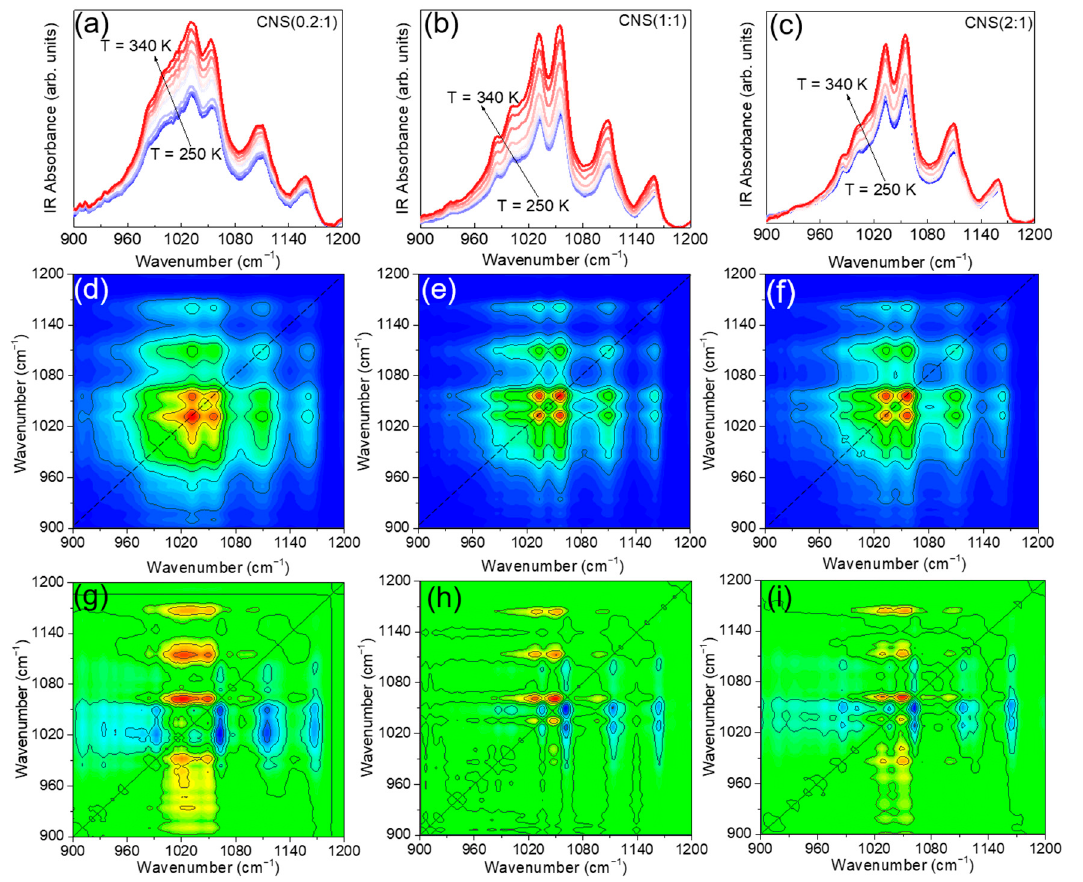
Figure 3. Temperature-dependent FTIR-ATR spectra ( a – c ) of the investigated samples in the 900–1200 cm − 1 wavenumber range; corresponding, synchronous and asynchronous 2D correlation maps (SCMs and ACMs) for CNS (0.2:1) (( d ) and ( g ), respectively), CNS (1:1) (( e ) and ( h ), respectively) and CNS (2:1) (( f ) and ( i ), respectively). In the case of SCMs, red- colored regions define positive correlation intensity ( Θ ( v 1 , v 2 ) > 0), whereas blue-colored areas account for a Θ ( v 1 , v 2 ) ~ 0 condition. Conversely, in ACMs, red, green and blue-colored areas describe positive, null and negative correlation intensities, respectively. See text for